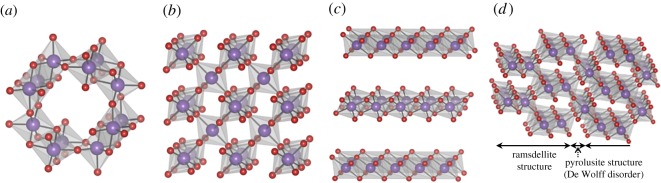
Schematic of the crystal structures of (a) α-MnO2, (b) β-MnO2, (c) δ-MnO2 and (d) γ-MnO2.